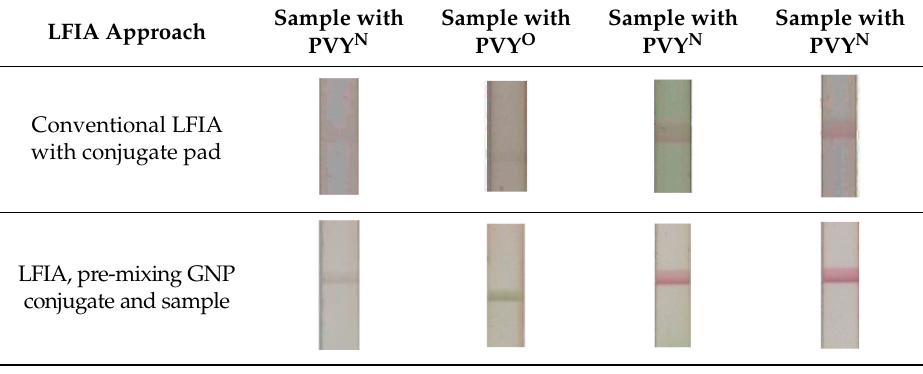
Table 1. Results of conventional LFIA and developed LFIA based on pre-mixing the GNP conjugate and the sample of potato leaf extracts. PVY O : ordinary or common strain of